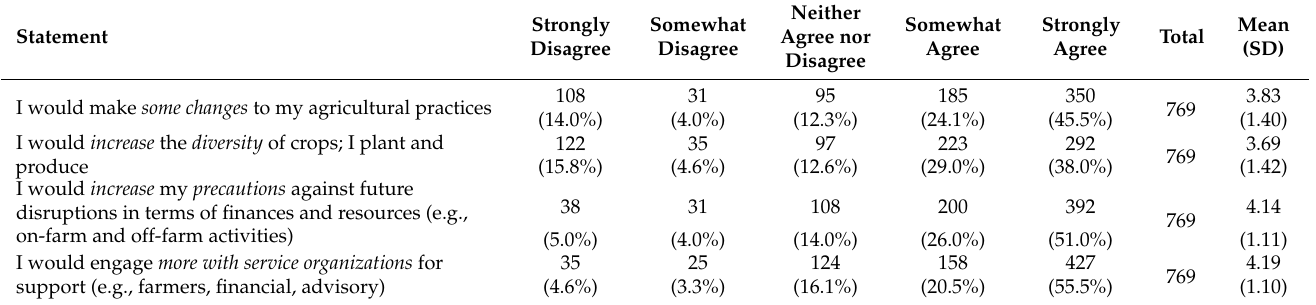
Table 15. Thinking about your experience of what has occurred due to COVID-19, please indicate your agreement or disagreement with the following statements related to what you would do differently for the next agricultural cycle if